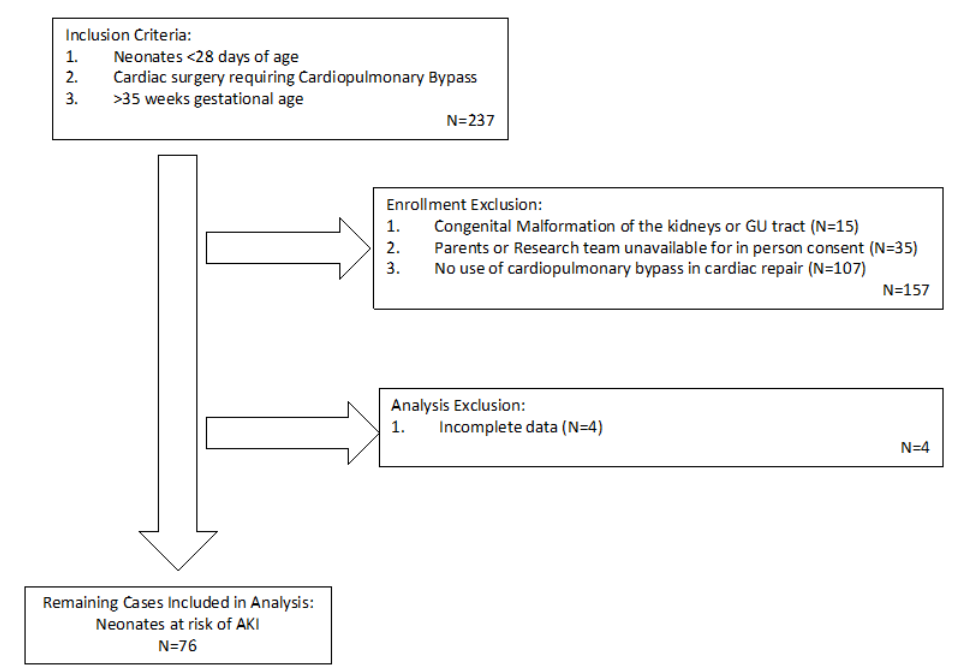
Figure 1. Flow chart of enrollment. AKI, acute kidney injury; GU, genitourinary.